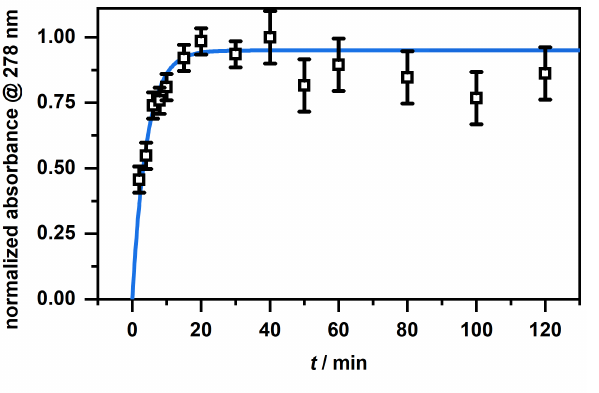
Figure 9. Time-dependent release of CBD in EtOH at 40°C as a plot of the normalized absorbance at 278nm, obtained from the UV/Vis measurements, against time.